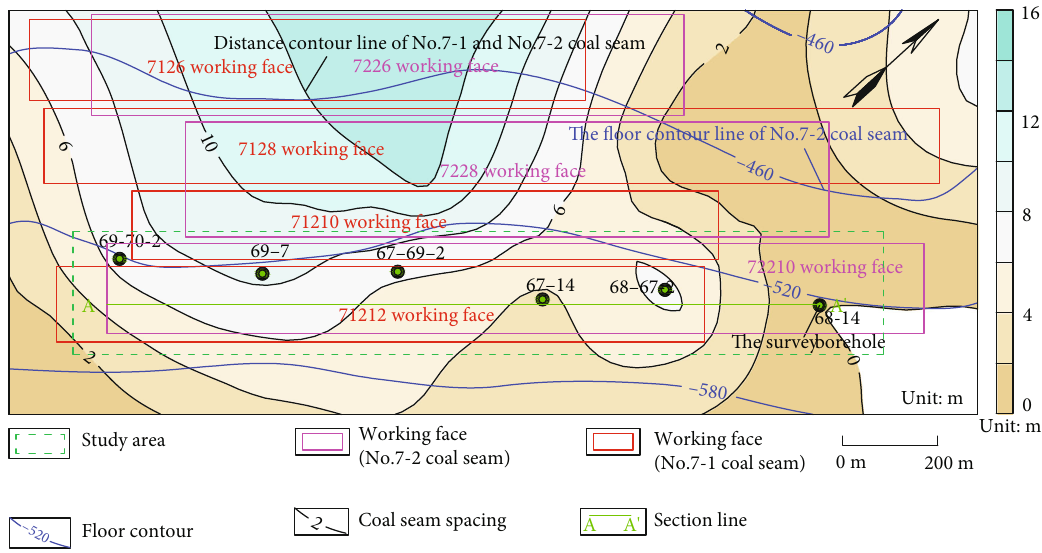
Figure 2: Plane layout of the working